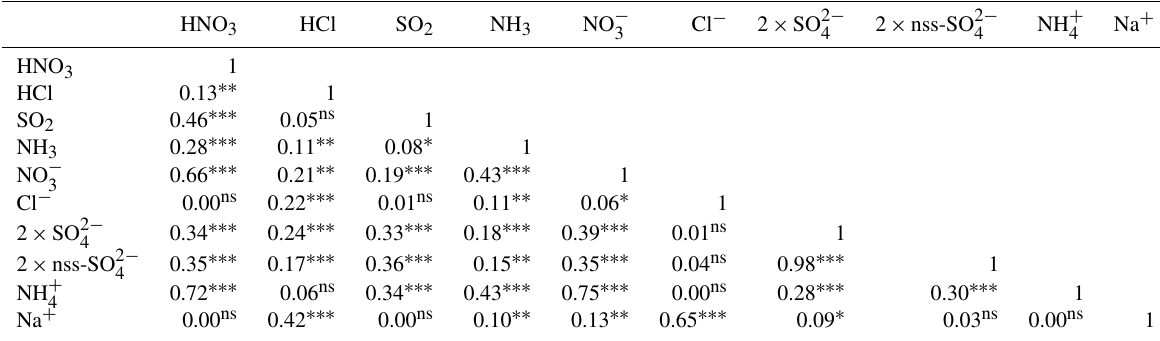
Table 5. Regression correlations ( R 2 ) between the mean molar concentrations (nmol m − 3 ) of gas and aerosol components at sites ( n = 66) in the NEU DELTA ® network.